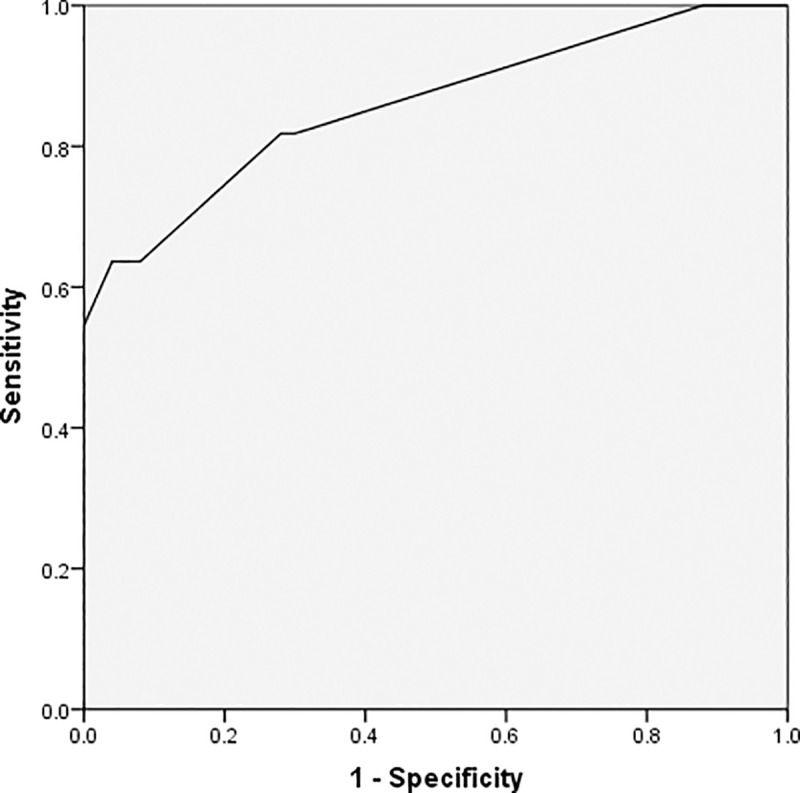
Receiver operating characteristic curve of the multivariate prediction model.